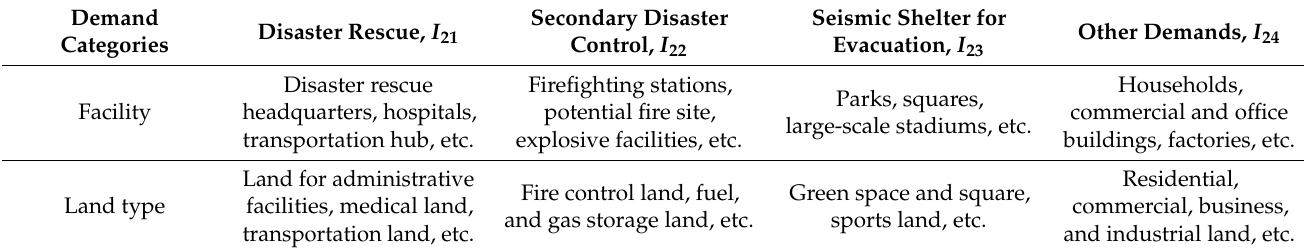
Table 1. Water demand category for post-earthquake rescue and disaster reduction service.